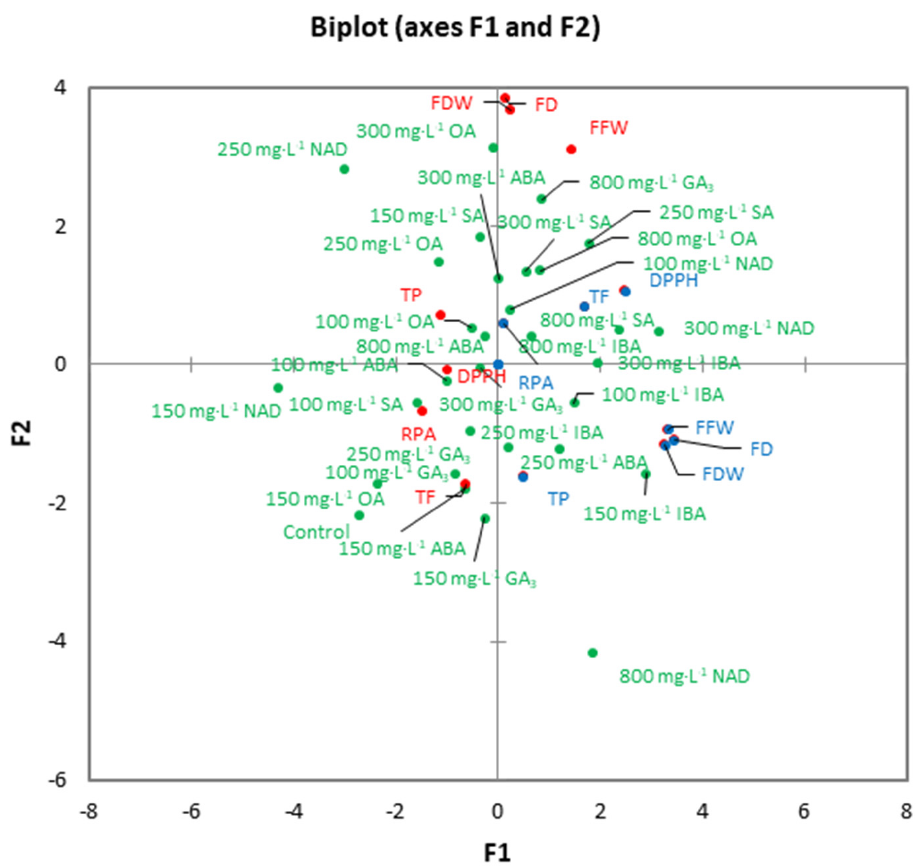
Figure 9. Principal component analysis among PGRs treatments and various flower growth and antioxidant attributes of two cultivars of marigold (“Pusa Narangi Gainda” and “Pusa Basanthi Gainda”). The treatments are shown in green colour, while variables of “Narangi” and “Basanthi” are indicated by red and blue coloured labels, respectively. Abbreviations: FD—flower diameter;